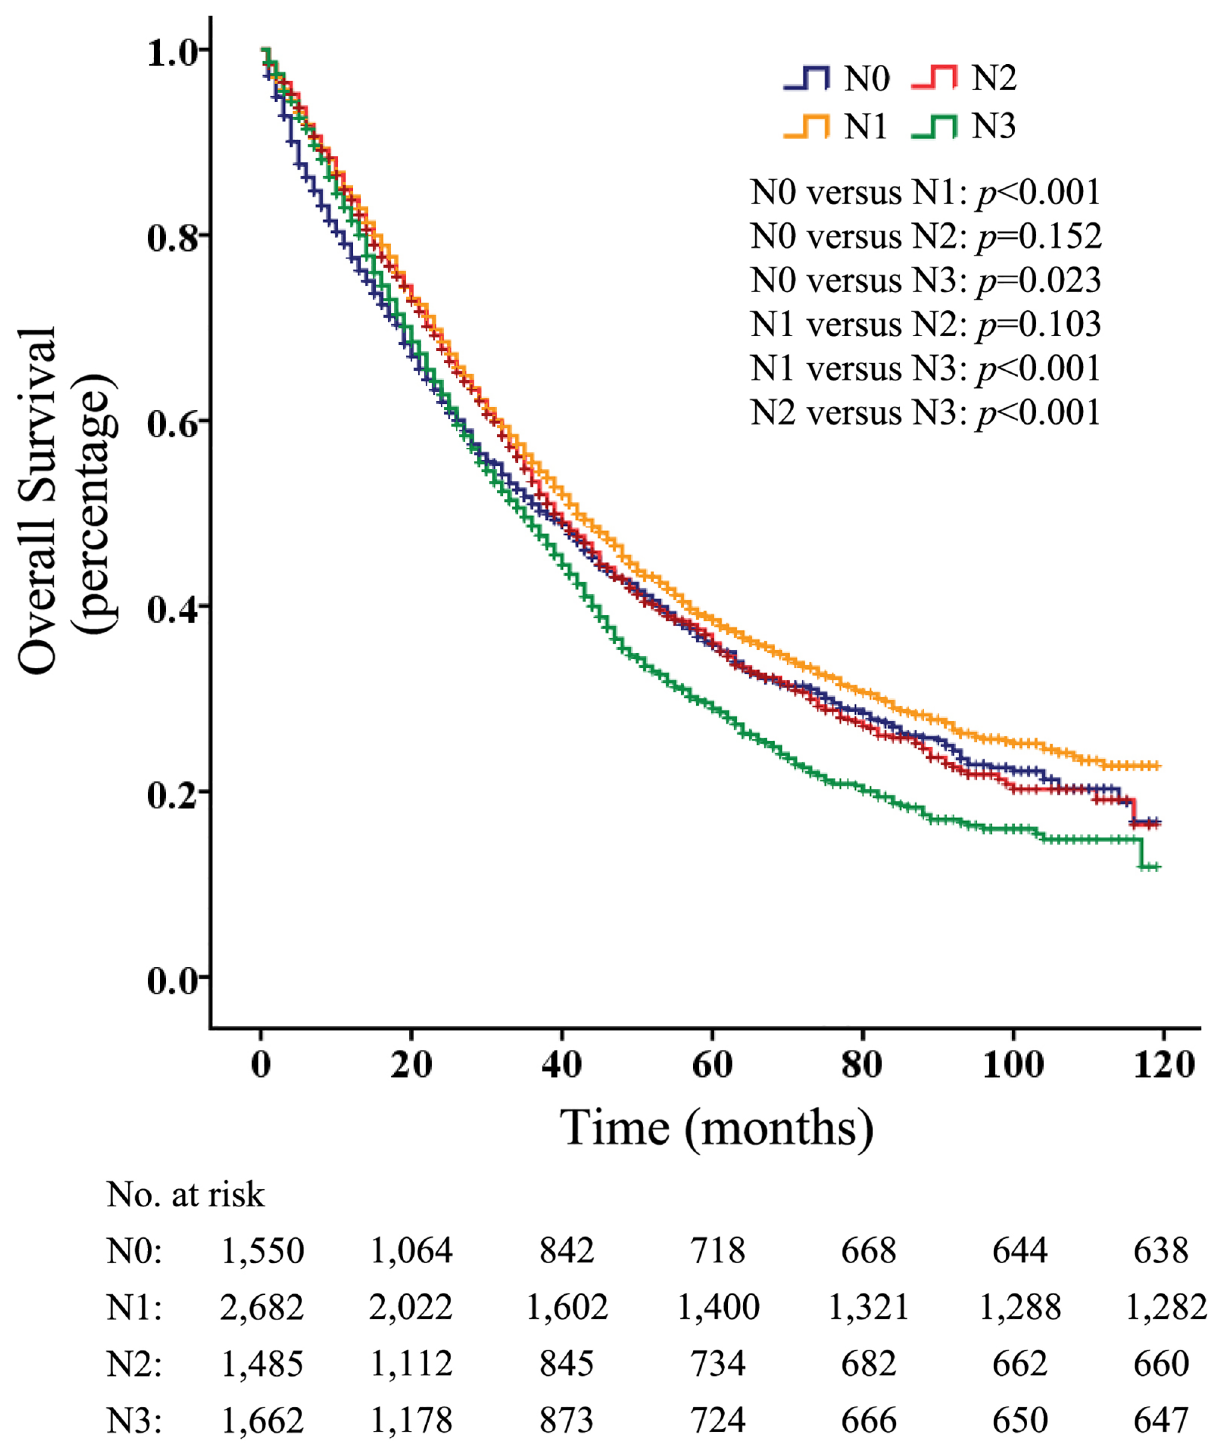
Fig 1. Overall survival according to N categories in patients with M1 breast cancer.